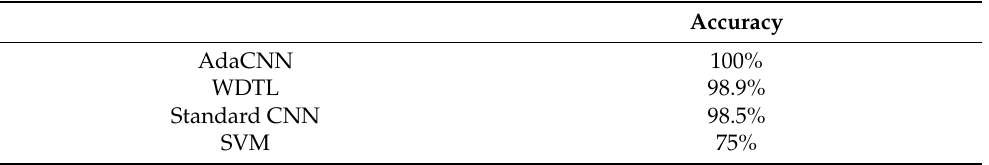
Table 3. The accuracy of knowledge transfer, in the case of adding noise 4 db, under different work- ing conditions